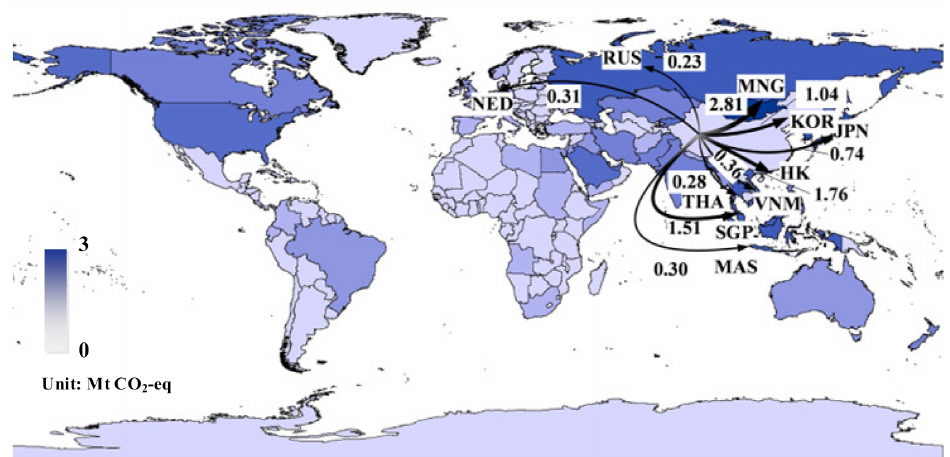
Figure 4. Major GHG emission flows embodied in China’s export of agricultural products in